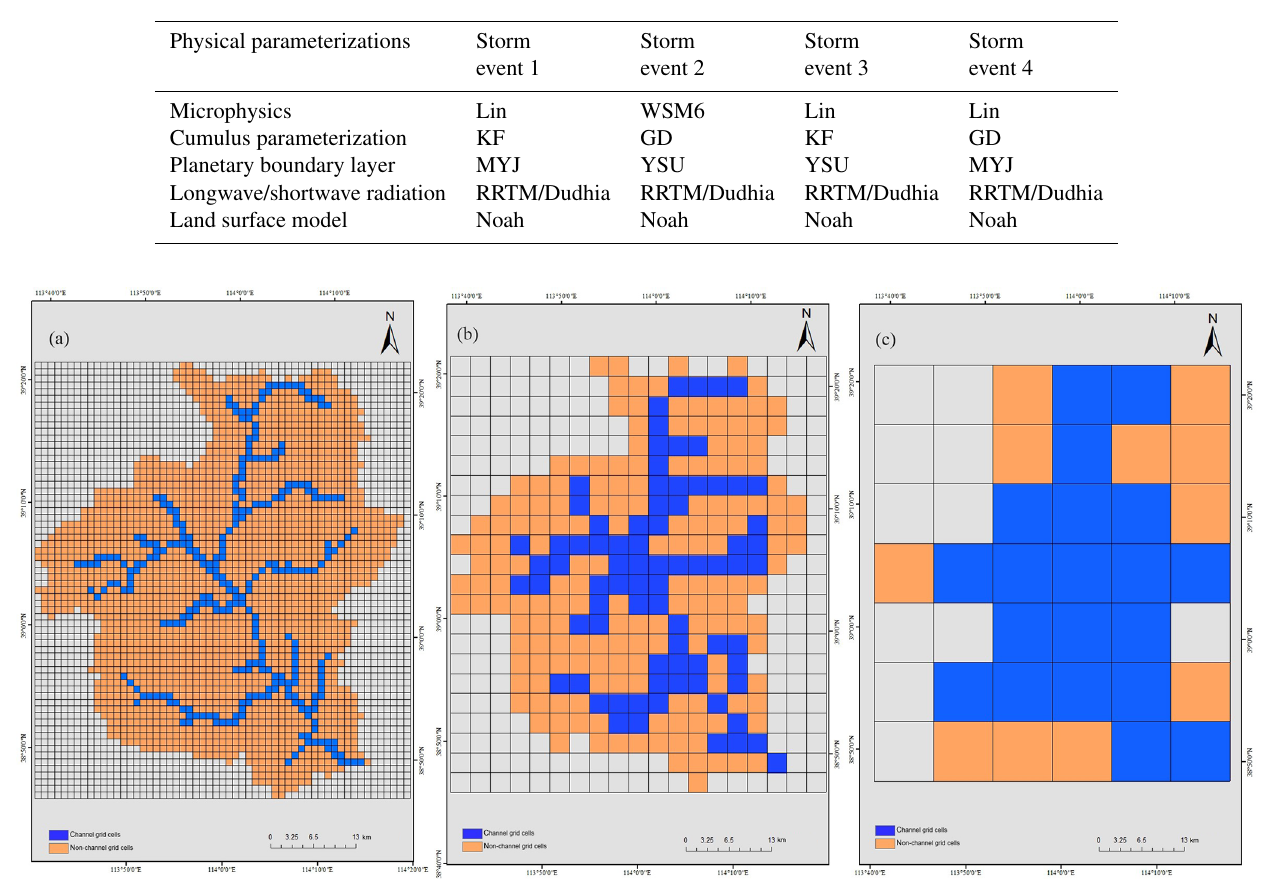
Table 5. Physical parameterizations adopted for the selected storm events.